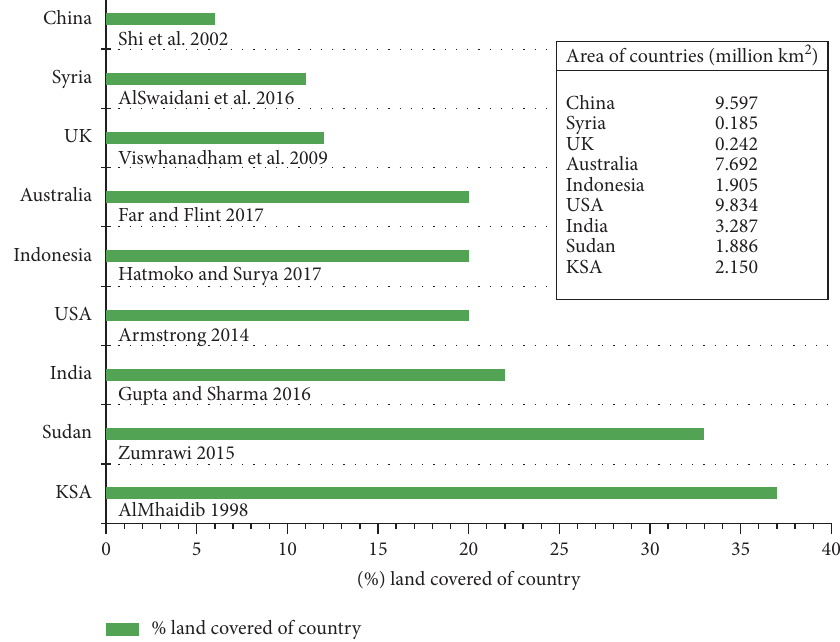
Figure 1: Percentage of covered area of expansive soils across diferent countries where such soils are found in abundance